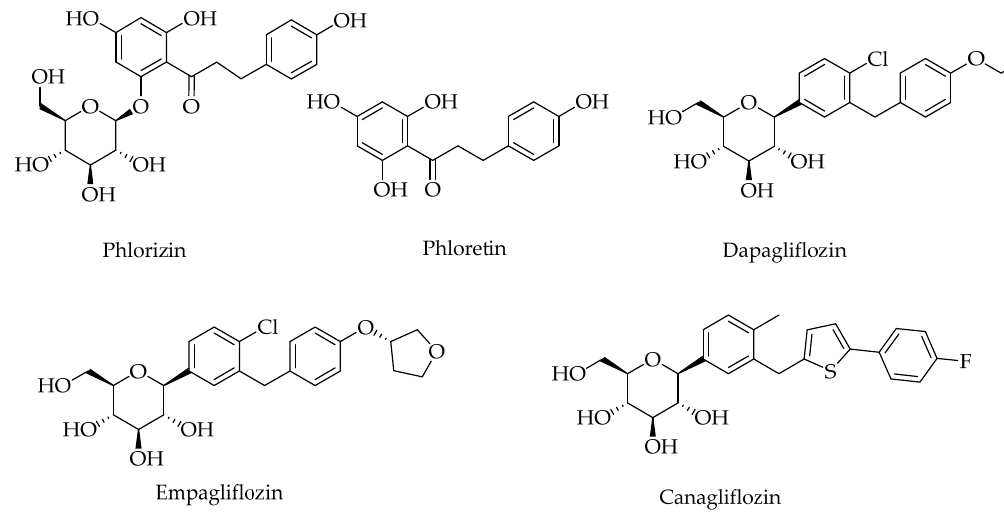
Figure 1. Structures of phlorizin, phloretin, and some selective SGLT2 inhibitors.